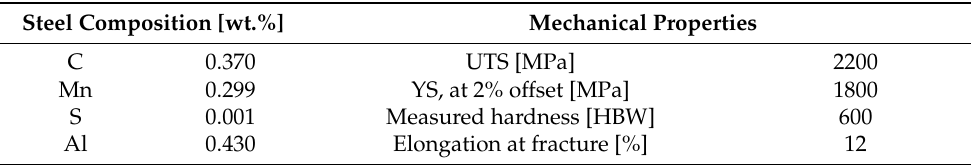
Figure 1. Microstructure of the studied steel showing dominantly a martensitic microstructure with bainitic islands indicated by yellow arrows (after etching with Nital 2% for 20 s). Table 1. Chemical composition and mechanical properties of the studied steel.